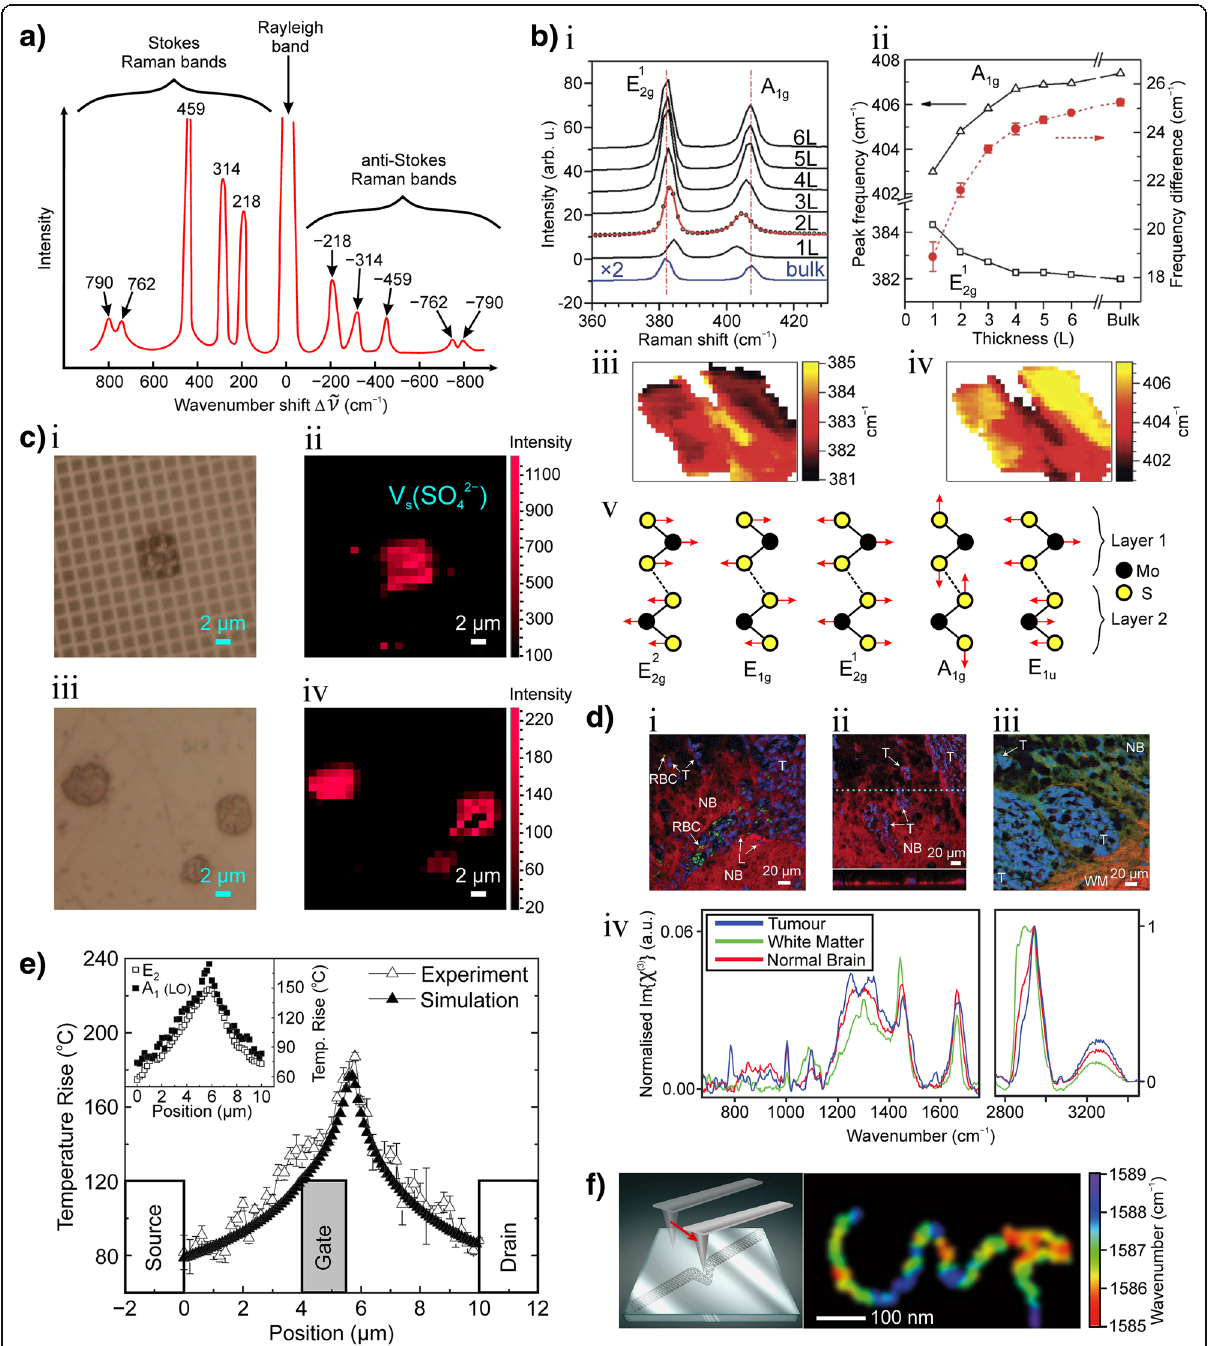
Fig. 5 (See legend on next